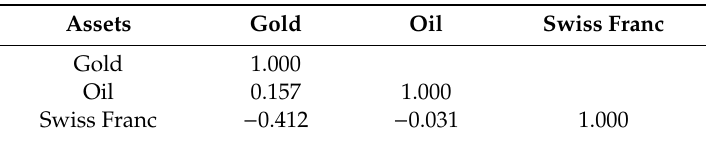
Table 2. Correlation matrix of asset